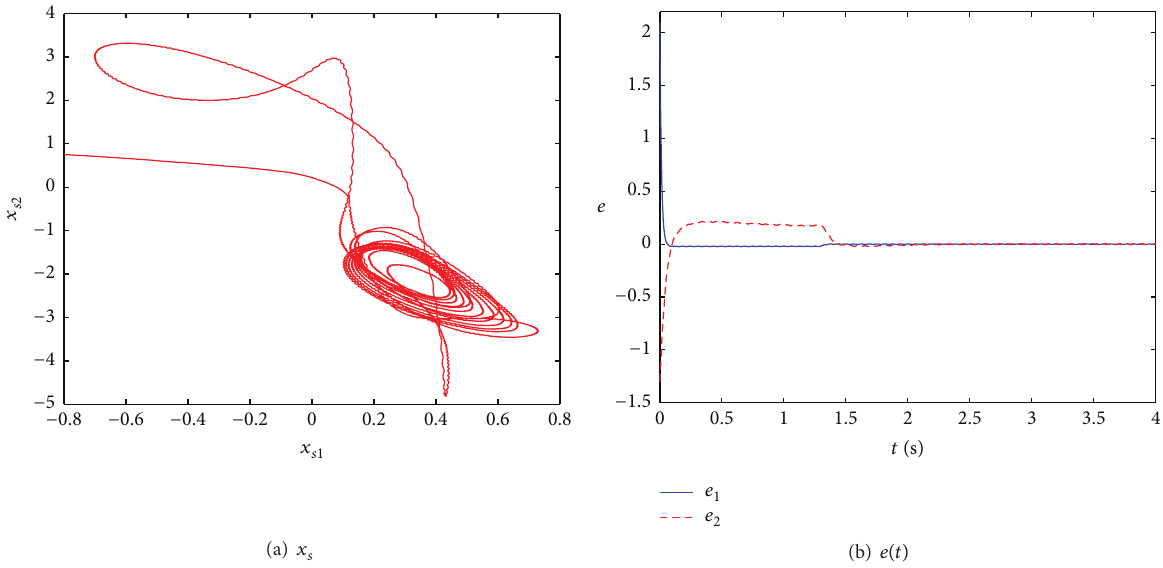
Figure 3: Behavior of the drive and response systems with controller and disturbance: (a) phase trajectory of response system and (b) syn- chronization